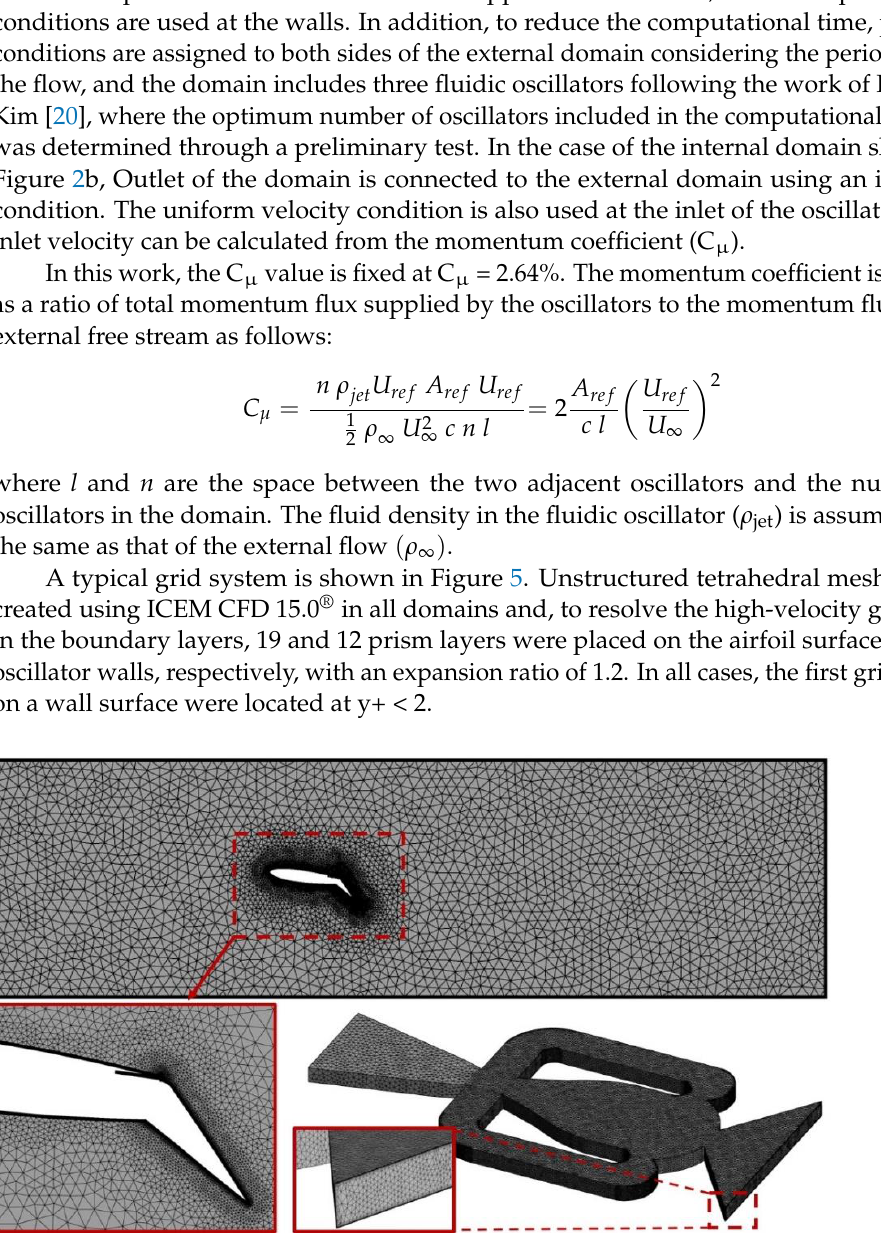
Figure 5. Grid system in internal and external domains.